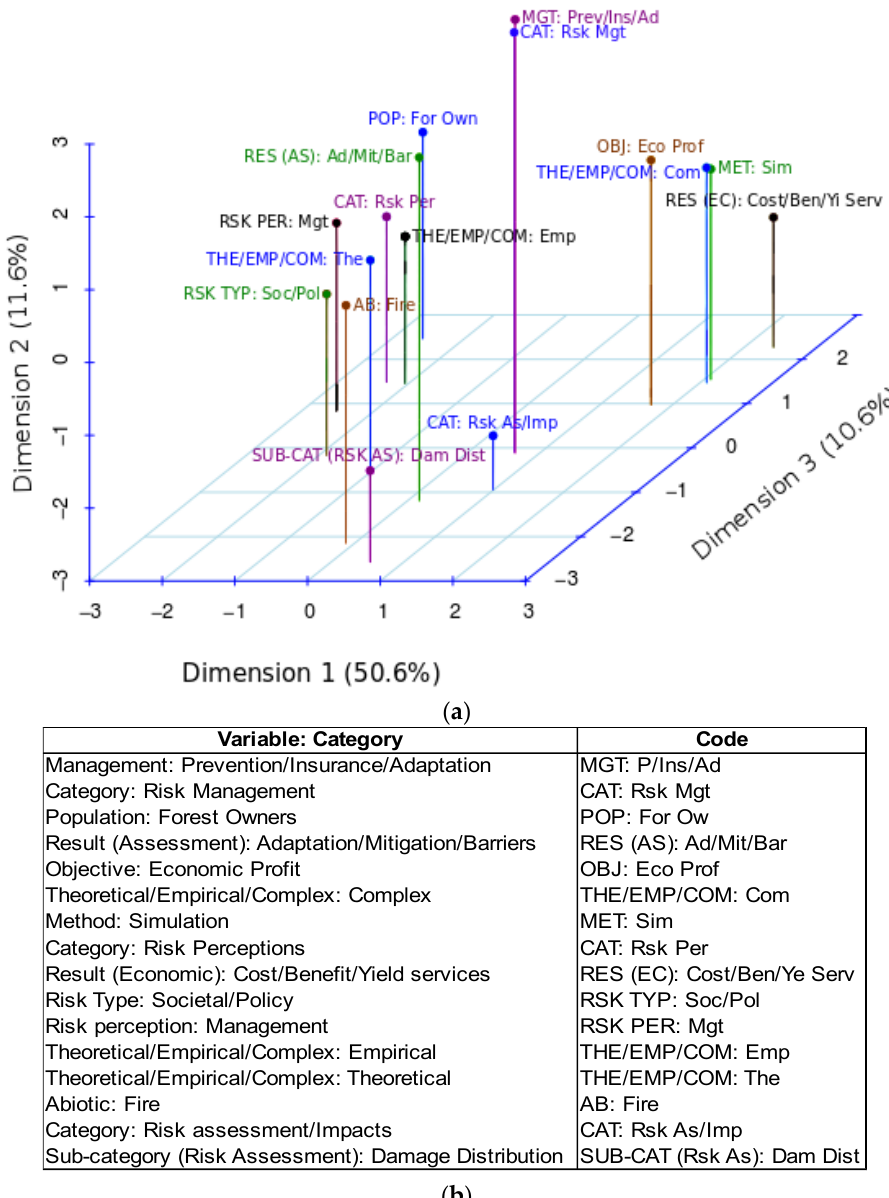
Figure 1. Graphical representation of the results of the Multiple correspondence analysis (MCA). ( a ) Dimensional presentation of the 16 combinations of variables and modalities contributing to more than 4% of the total variance of each dimension; ( b ) The variables and their associated codes in the dimensional representation.